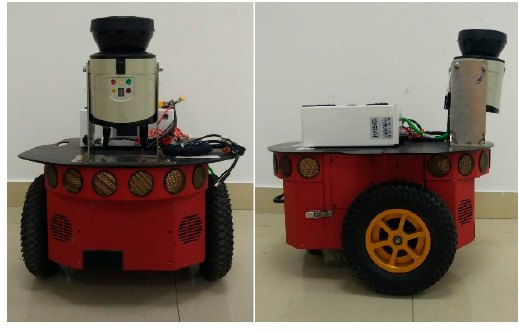
Figure 5. ‘Pioneer3’ mobile robot. Table 2. Configuration Parameters for LiDAR Sensor.